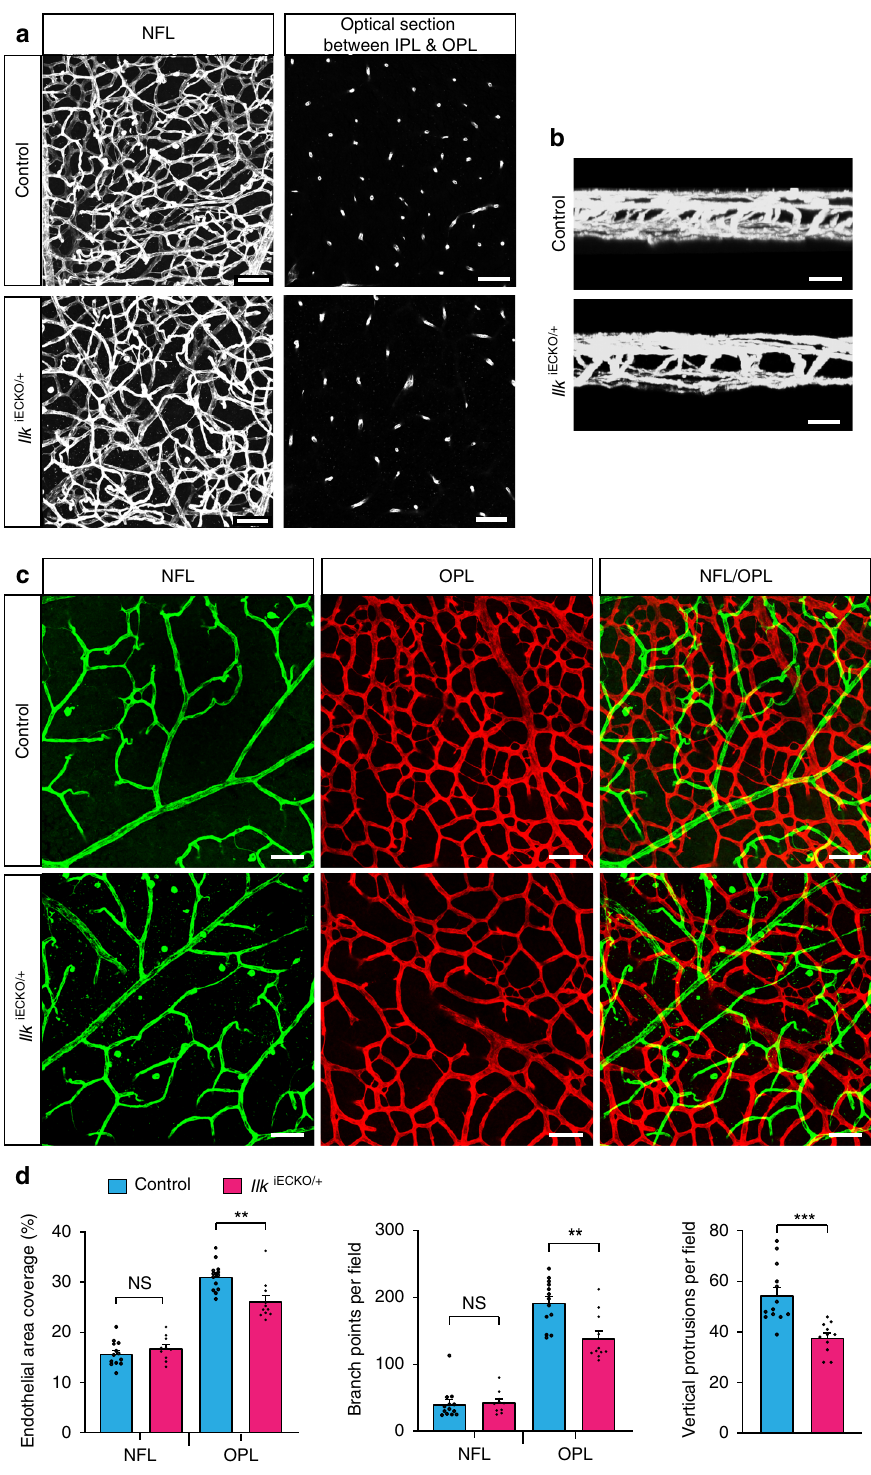
Fig. 5 Vascular defects in Ilk iECKO/ + heterozygotes. a , b Extended focus ( a :XY; b :XZ) and optical section images (right panels in a ) of isolectin B4-stained P17 control and Ilk iECKO/ + retinal wholemounts. Vessel density and vertical sprouts between IPL and OPL are reduced in Ilk iECKO/ + . Scale bar, 50 μ m in ( a ) and 25 μ m in ( b ). c , d Images of isolectin B4-stained control and Ilk iECKO/ + retinal vessels with pseudo-coloring of the NFL (green) and OPL (red) vasculature ( c ). Scale bar, 50 μ m. Ilk iECKO/ + OPL EC area, branch points and vertical sprouts are reduced, whereas NFL vessels are comparable to control samples ( d ). Error bars, s.e.m. p values (*** p < 0.001, ** p < 0.01, ns not signi fi cant), Student ’ s t test ( n = 3 retinas/group). Source data are provided as a Source Data fi